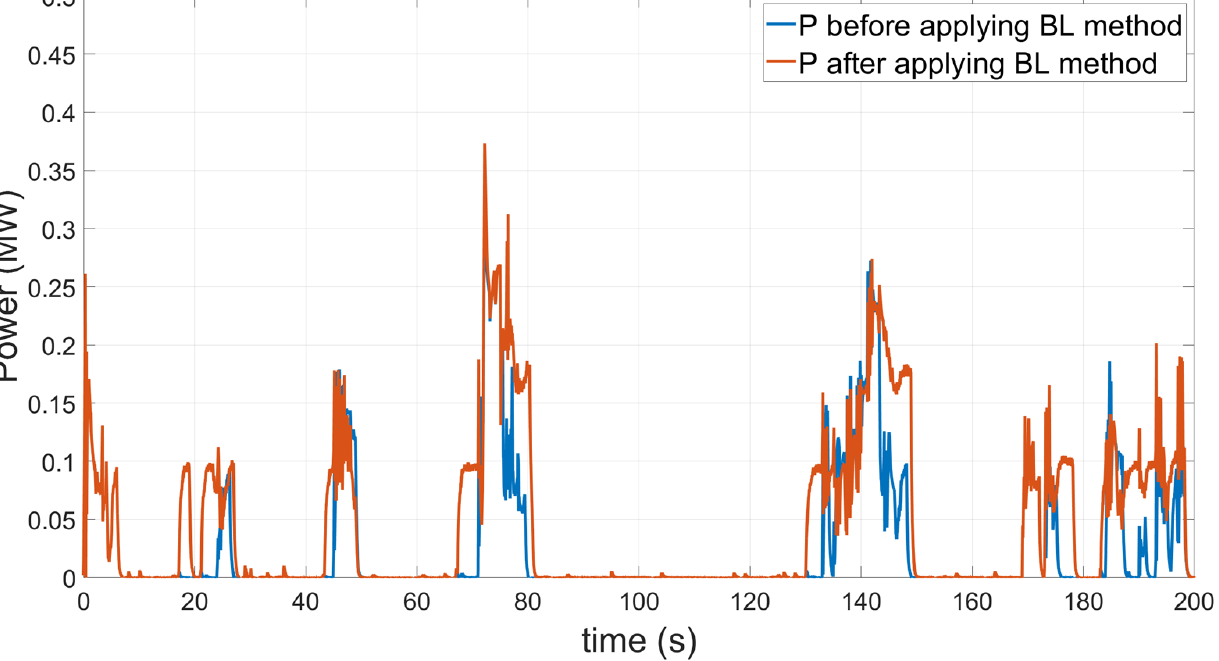
Figure 11. Comparison of changes in regenerative energy utilization by inverter before and after BL method application.